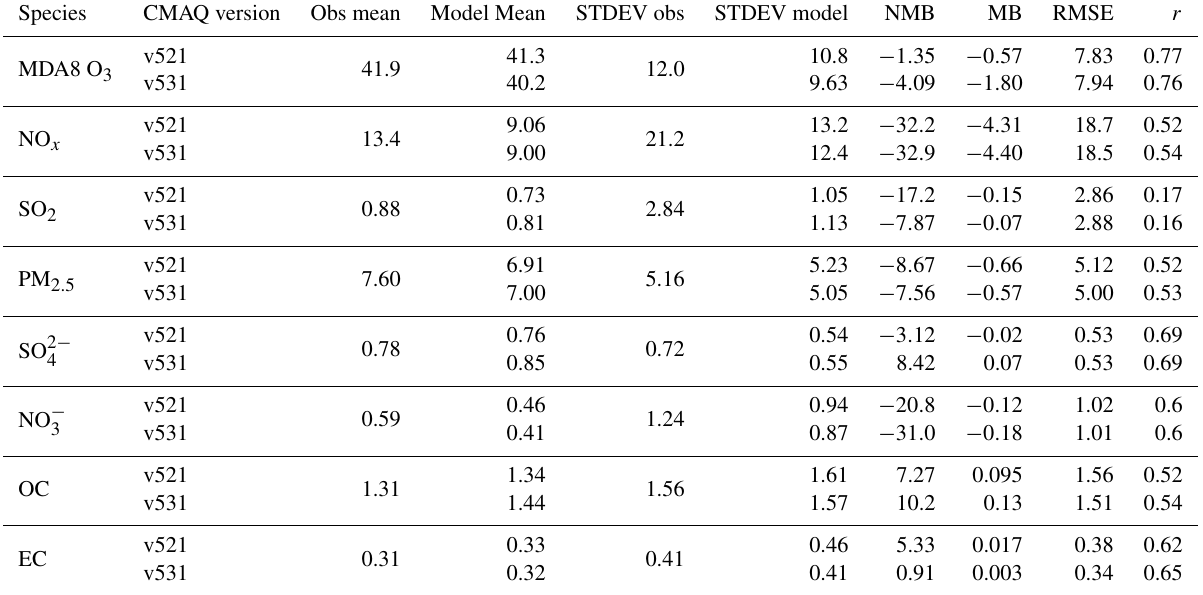
Table 2. Annual average performance metrics for all AQS sites for the CMAQ521 (v521) and CMAQ531_WRF411_M3Dry_BiDi (v531) simulations. Gas species are in units of ppbv; PM species are in units of µgm − 3